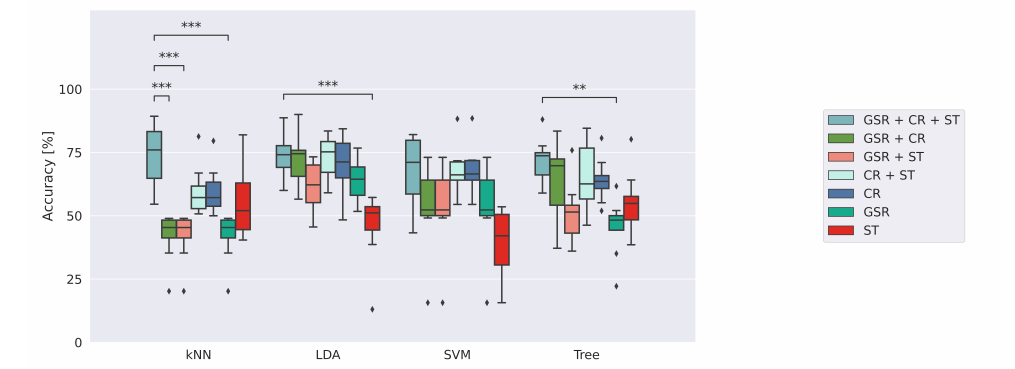
Figure 6. Accuracy of the implemented classifiers trained with different sensorial inputs. The ** and *** denote comparisons in which 0.001 < p -value ≤ 0.01 and p -value ≤ 0.001, respectively.